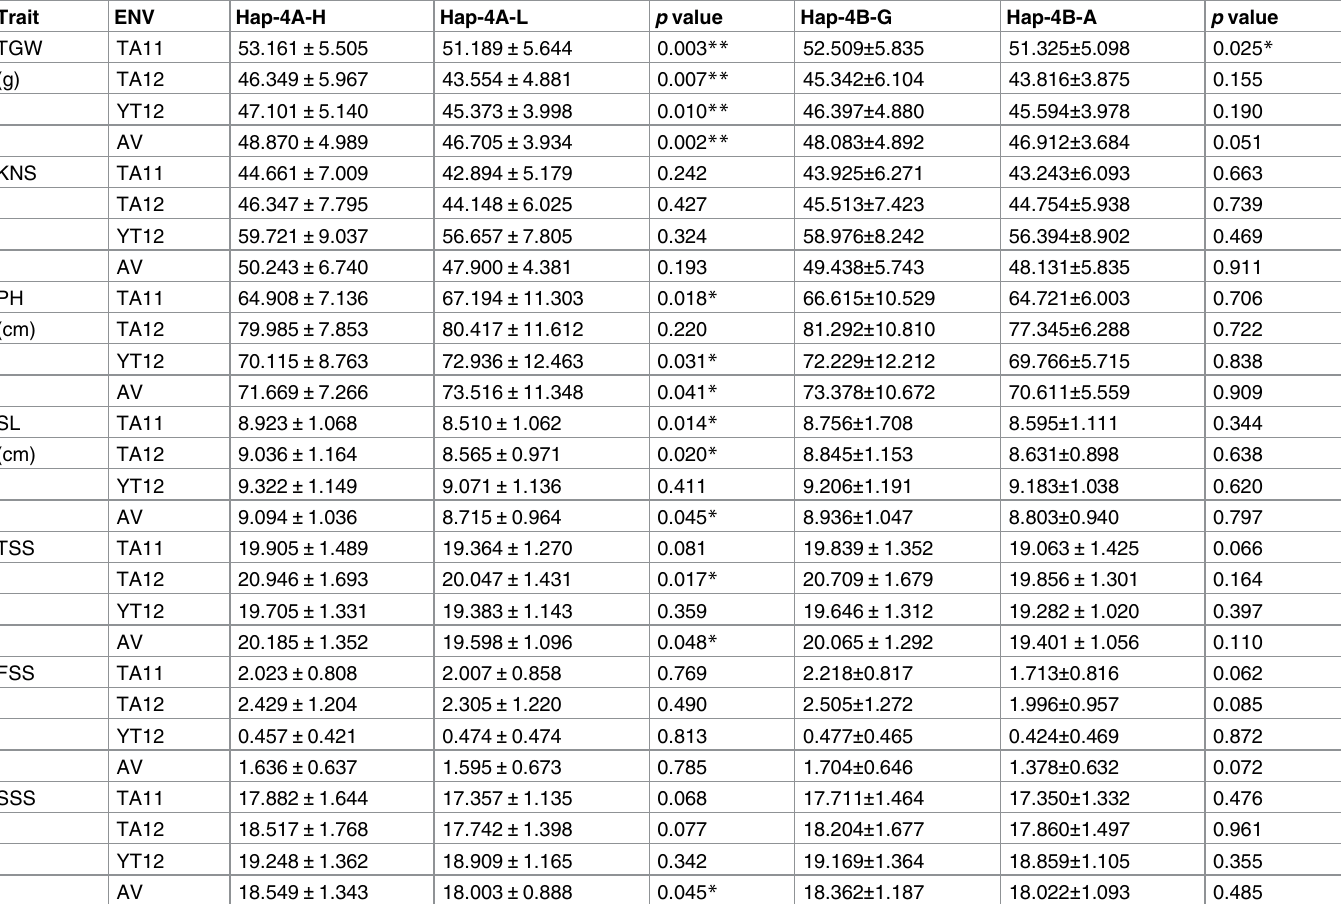
Table 2. Association analysis between the haplotypes and agronomic